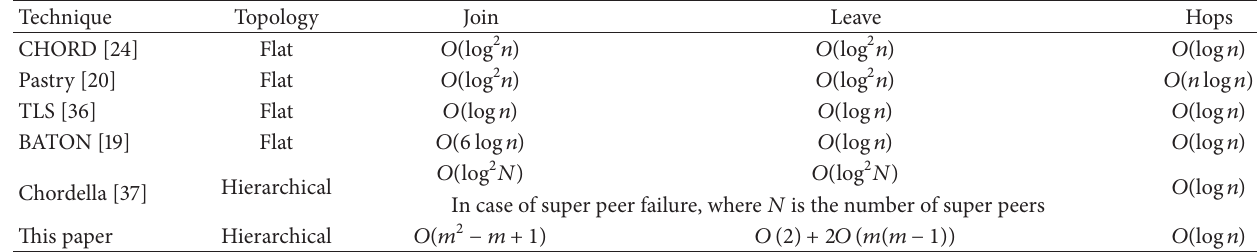
Table 1: Comparison of performance of different overlay